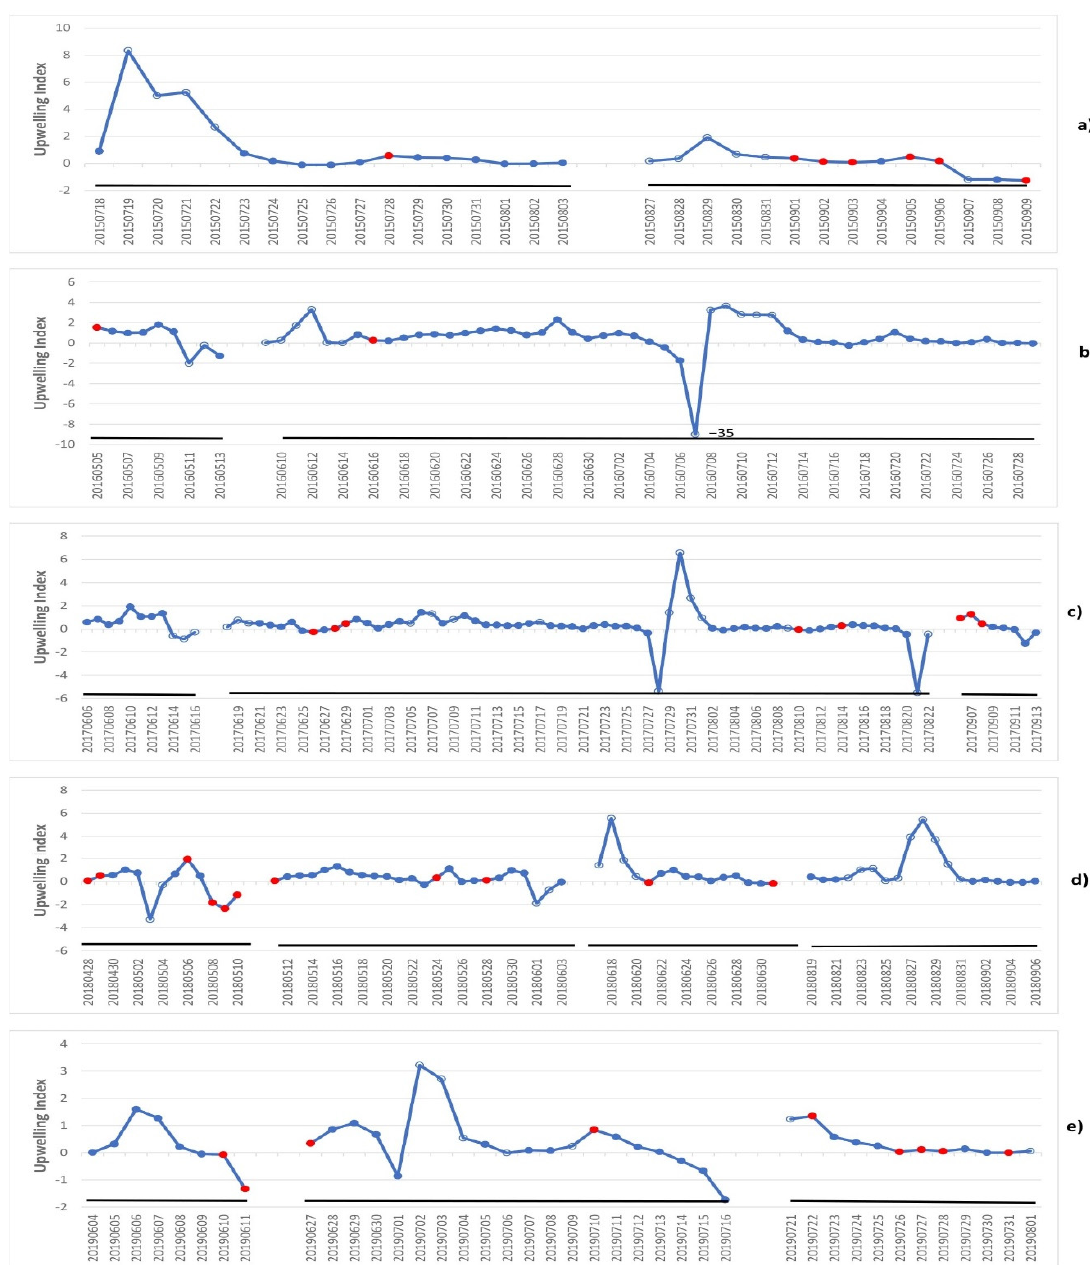
Figure 4. Time-series of the significant upwelling-favorable wind events at the central location; ( a ) 2015, ( b ) 2016, ( c ) 2017, ( d ) 2018, ( e ) 2019. Symbols as Figure 3. The labelled value(s) are actual UI value(s) that could not be properly